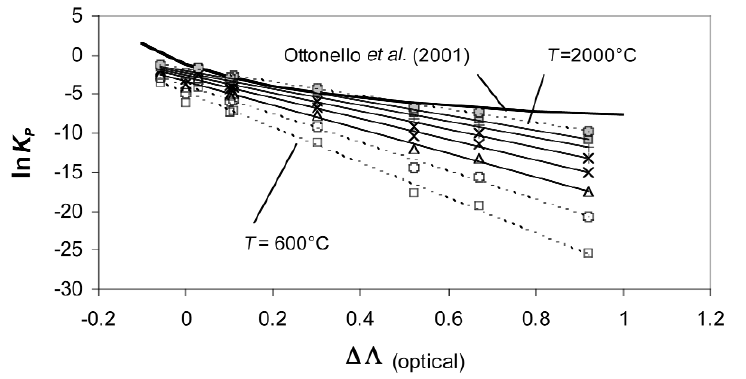
Fig. 5. Polymerization constant in MO-SiO 2 melts at various T (with MO = basic oxide) plotted against differ- ence in optical basicity of MO and SiO 2 (adopted basicity values are those of column 6 in table A1 of Ottonel- lo et al ., 2001). Selection of other basicity values within uncertainty ranges (columns 1 to 6 in same table) do not greatly alter observed relations. Dashed lines: extrapolations at T beyond T limits investigated here for most basic oxides. Solid heavy line: functional form adopted by Ottonello et al . (2001) and Moretti and Ottonello (2003) when role of T was still